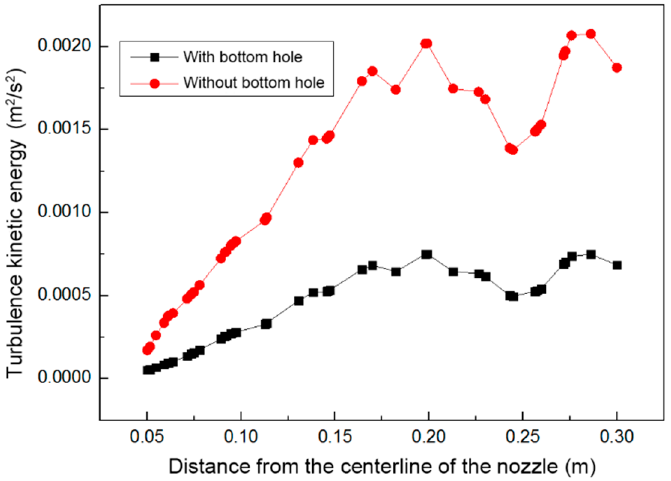
Figure 11. Turbulent kinetic energy distribution of liquid surface with different nozzle bottoms.